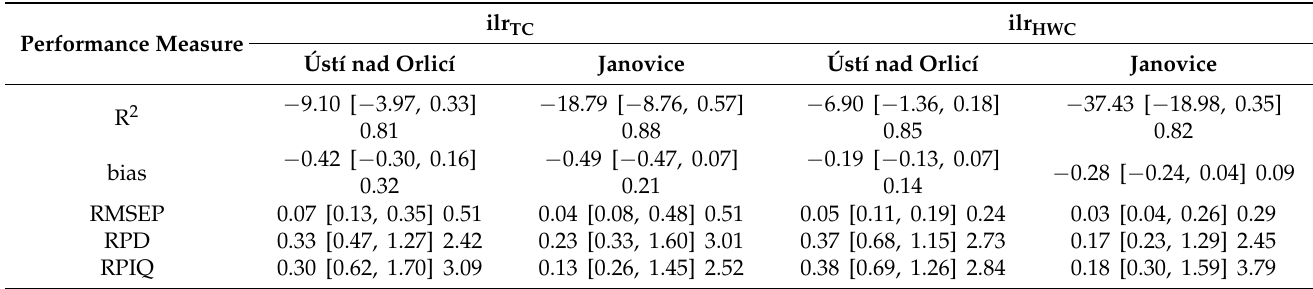
Table 3. Ranges of PLSR model performance measures according to the dependent variable and the target site. The values outside and inside the brackets correspond to performances obtained for individual data partitionings and performances that were median aggregated across the partition- ings,